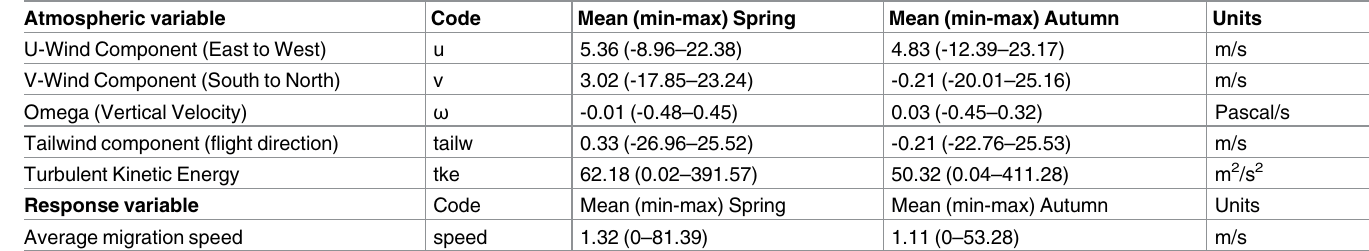
Table 1. List of environmental variables included in quantile regression of hourly speed of Americanwhite pelicans